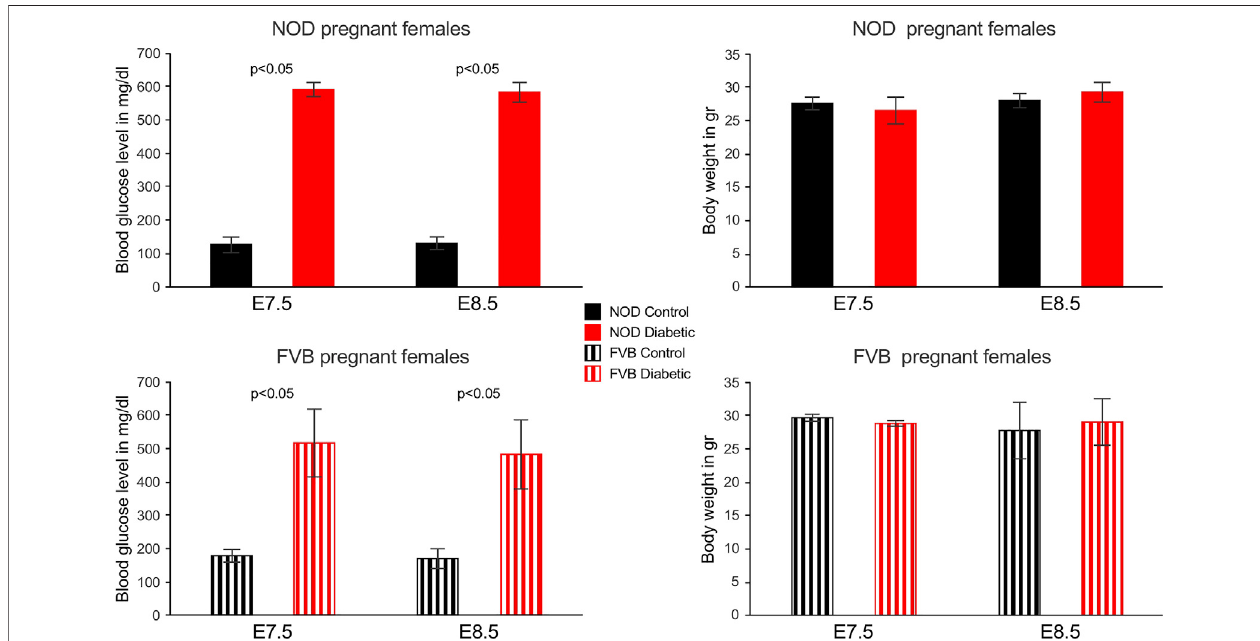
FIGURE 1 | Blood glucose levels and weights of pregnant mouse dams. Blood glucose levels were measured weekly in NOD females and in FVB females after Streptozotocin administration, on the day of mating, and again at the time of sacri fi ce. All diabetic females exhibited glocuse levels higher than 360 mg/dl at the time of sacri fi ce,incaseswherereadingsexceededthescaleoftheglucometer,thevaluewassetto600 mg/dl(3outof5NODdamsatE7.5,4outof6NODdamsatE8.5,one out of 3 FVB dams at E7.5). Weights of dams did not signi fi cantly differ between groups or time points.